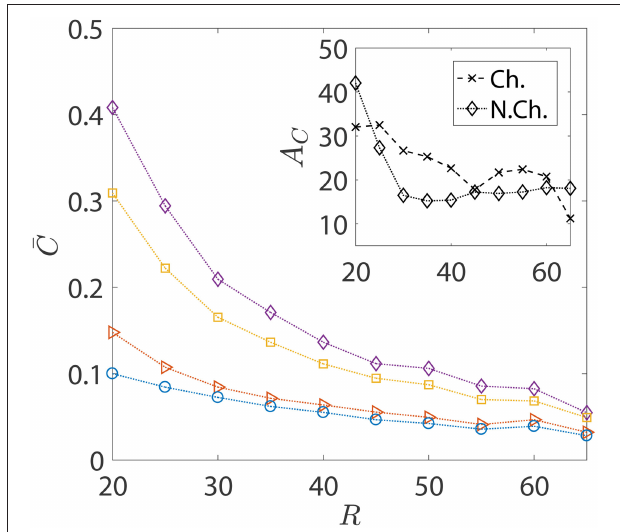
FIGURE 8 | The variation in the average nutrient exposure, ¯ C , for chemotactic and non-chemotactic bacteria, with strong and weak hydrodynamic interactions, as a function of the (dimensionless) radius of the marine snow particle R . The legends in the main figure are as follows: 3 − chemotactic, α D = 2; 2 − chemotactic, α D = 0.1; (cid:3) − non-chemotactic, α D = 2; (cid:13)− non-chemotactic, α D = 0.1. Inset: The hydrodynamic amplification, A C , as a function of R . The other parameters are: K 1ρ = 0.0109, τ ∗ = 1, Sc =